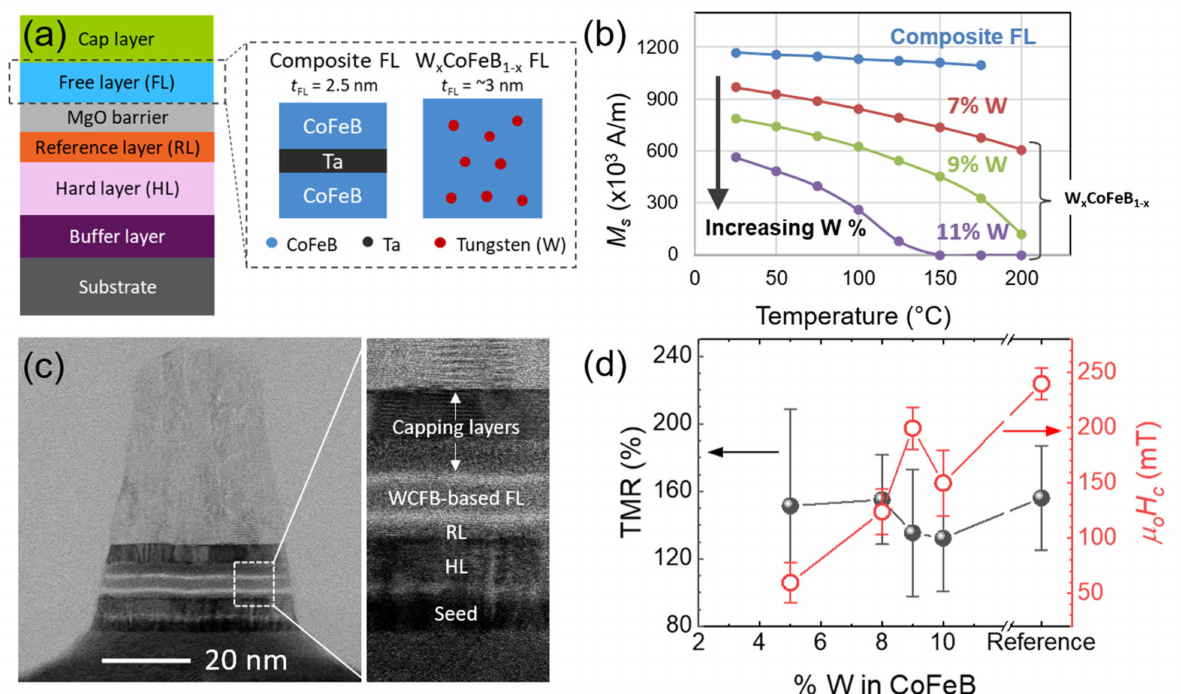
Figure 1. ( a ) Schematic of the pMTJ stack and the two free layer (FL) stack options. The hard layer (HL) is a [Co/Pt] x -based multilayer, and the reference layer is a [Co/spacer/FeB]-based trilayer stack. The HL and RL are coupled through a metallic spacer to form a synthetic antiferromagnet (SAF). The composite FL serves as the reference for this study; ( b ) temperature dependence of the saturation magnetization ( M s ) measured for the composite FL and W x CoFeB 1-x FL with varying W concentrations; ( c ) cross-sectional TEM image of a fully fabricated 50 nm CD device with FL = W 0.09 (CoFeB) 0.91 . The zoomed-in image shows good polycrystalline order at the RL/MgO/FL/MgO interfaces; ( d ) tunnel magnetoresistance (TMR) and magnetic coercivity ( µ o H c ) measured on 50 nm CD devices for varying W concentrations and the reference